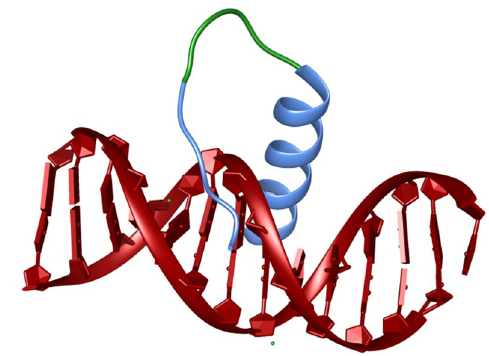
Figure 3. ( a ) Structure of SAP-1/SRF co-complex with target DNA (pdb1K6O); SAP-1 is a paralog of ELK-1; ( b ) Cartoon depiction of the synthetic transcription factor targeted against both ELK-1 and SRF sites. Magenta helix is the DNA major groove binding helix from Elk-1 protein; Magenta chain is a loop derived from SRF protein and binds to the DNA minor groove; Blue chain is the linker.